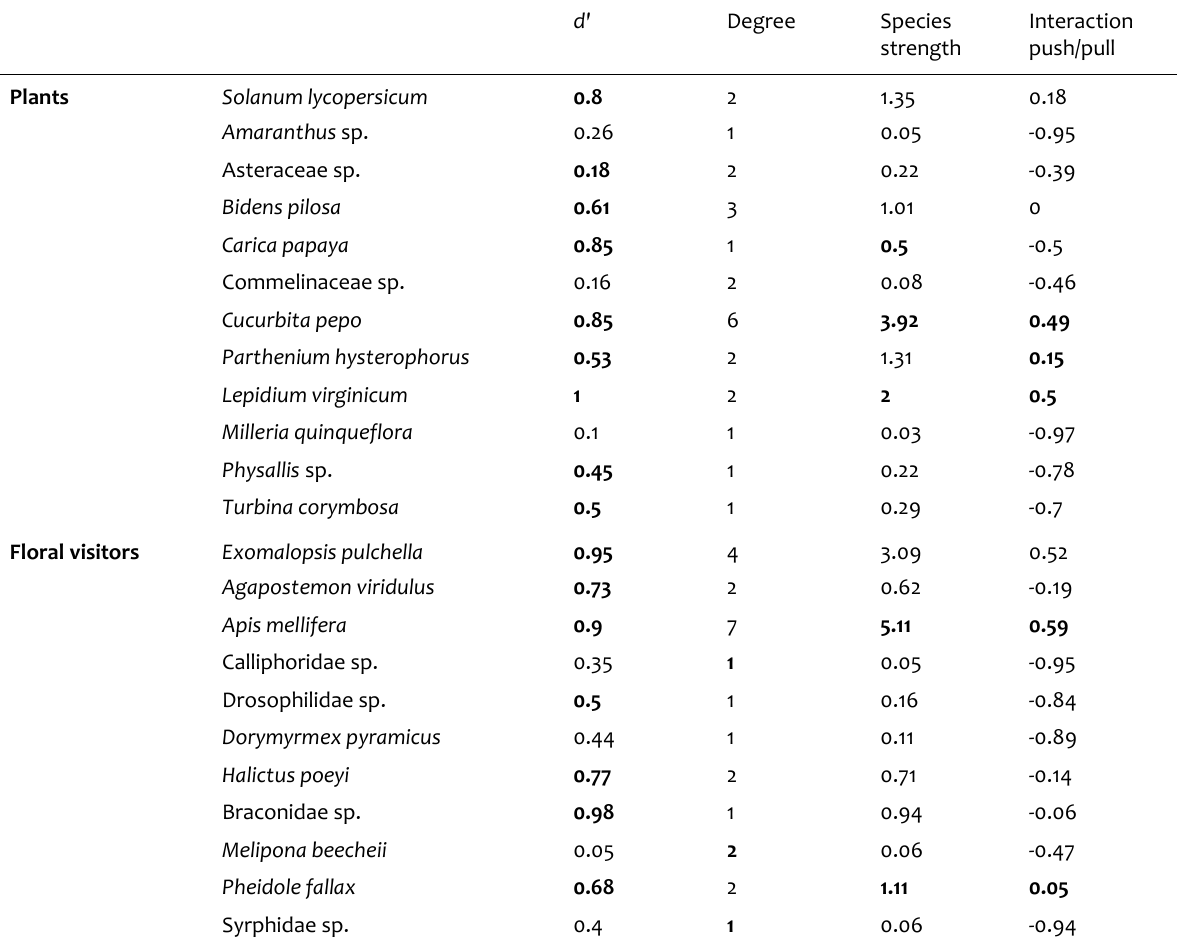
Table 1. Metrics for the species present in the pollination network in the agroecosystem of Mayabeque, Cuba, between November 2018 and March 2019. Values in bold are those significantly different from 1000 null